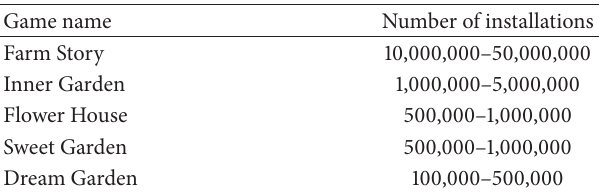
Table 1: Numbers of installations for five gardening games from Google Play